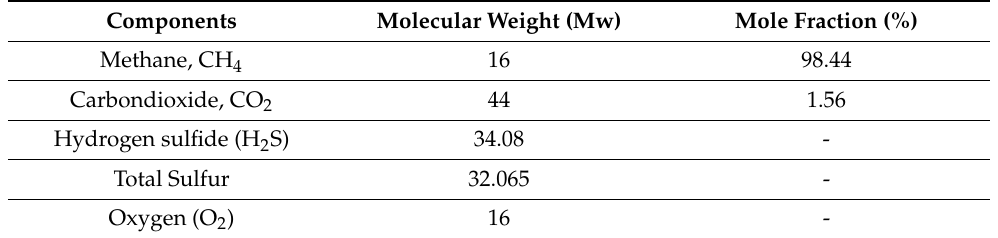
Scheme 1. Laboratory Mini Flow Loop for Hydrate Study. Table 1. Composition of Compressed Natural Gas Used. Table 1. Composition of Compressed Natural Gas